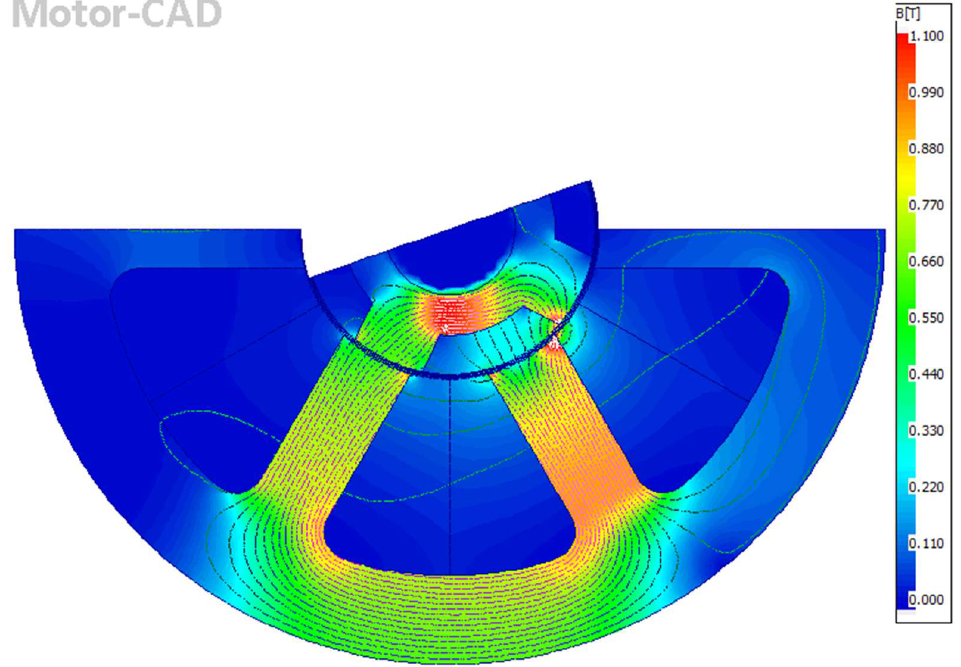
Table 10. Comparison of the electromagnetic parameters.